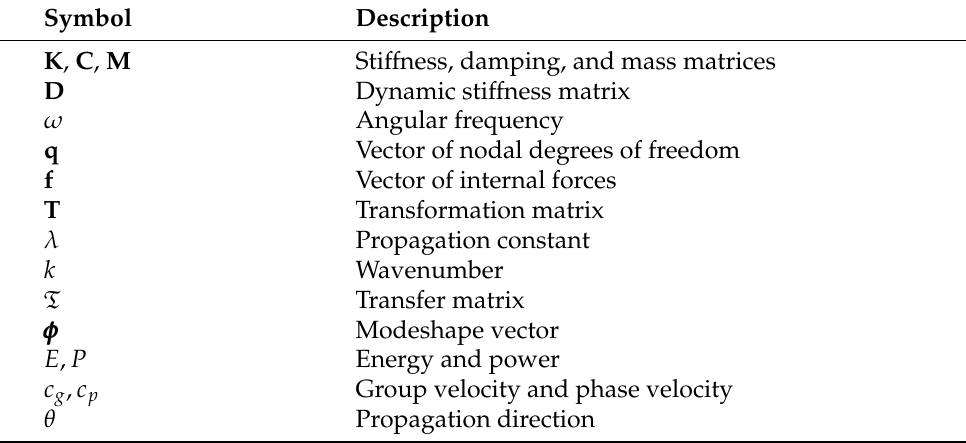
Table 1. List of